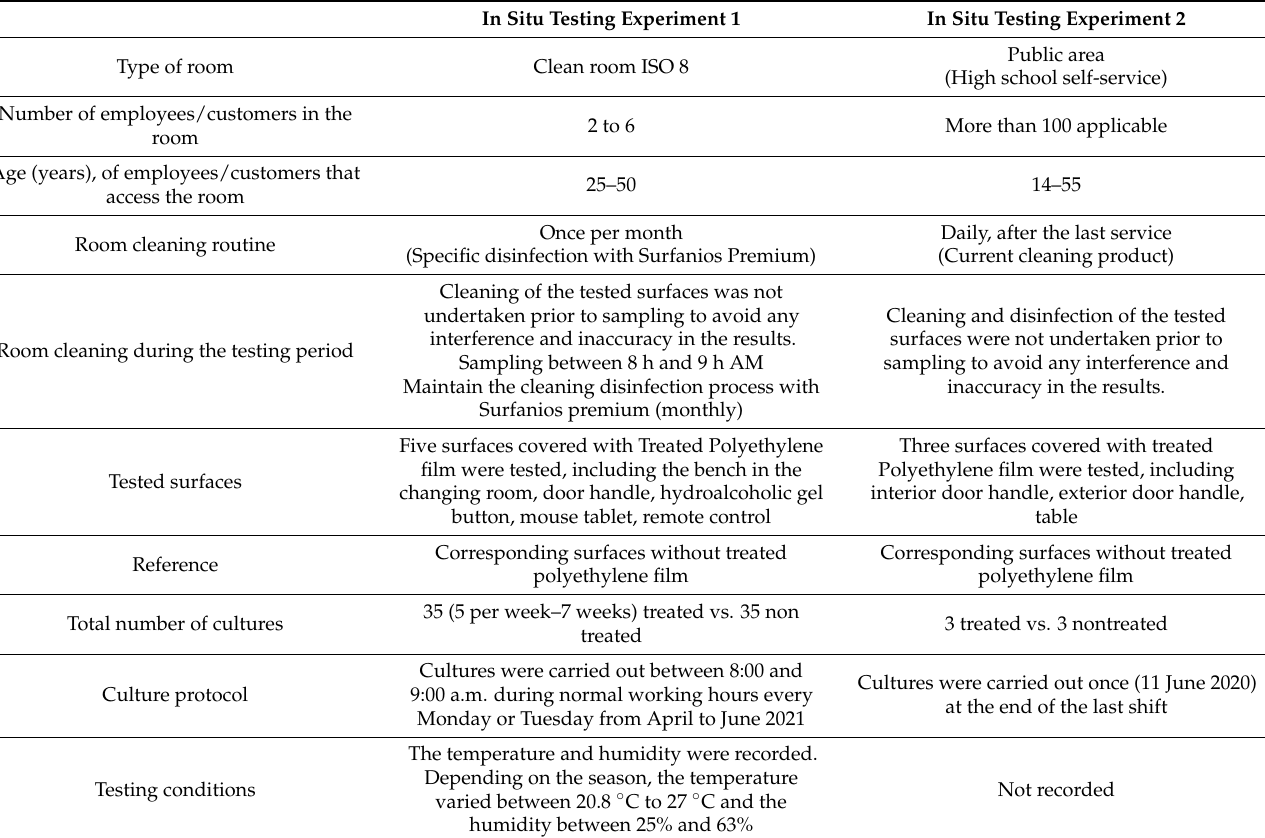
Table 2. In situ testing